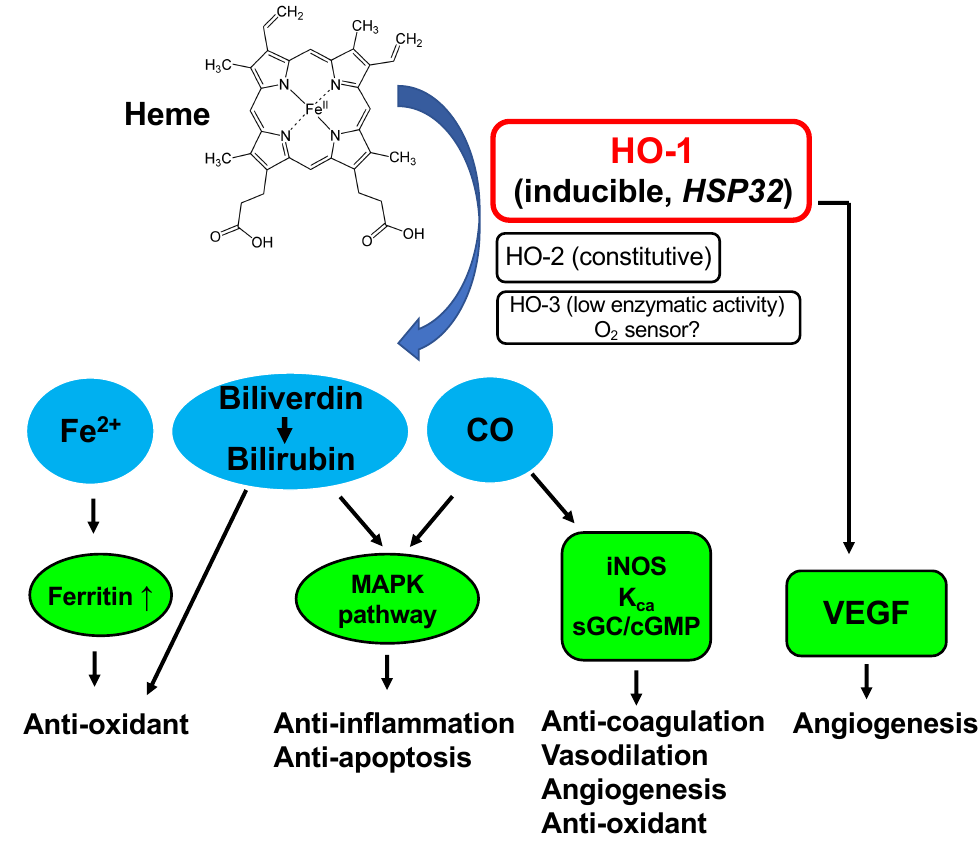
Figure 1. Schematic illustration of heme oxygenase (HO)-catalyzed heme degradation and the roles of